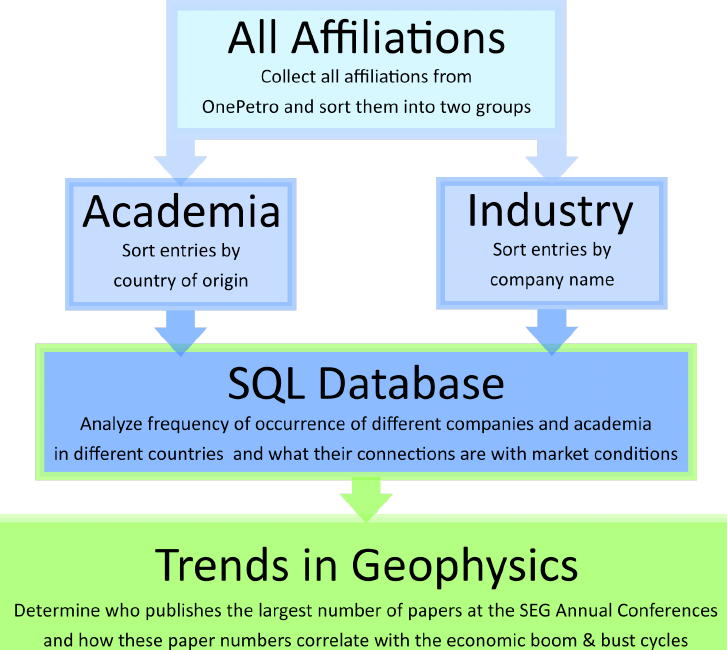
Figure 1. Data processing